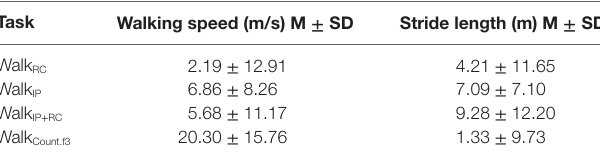
TaBle 4 | Dual task costs depending on the dual task type.